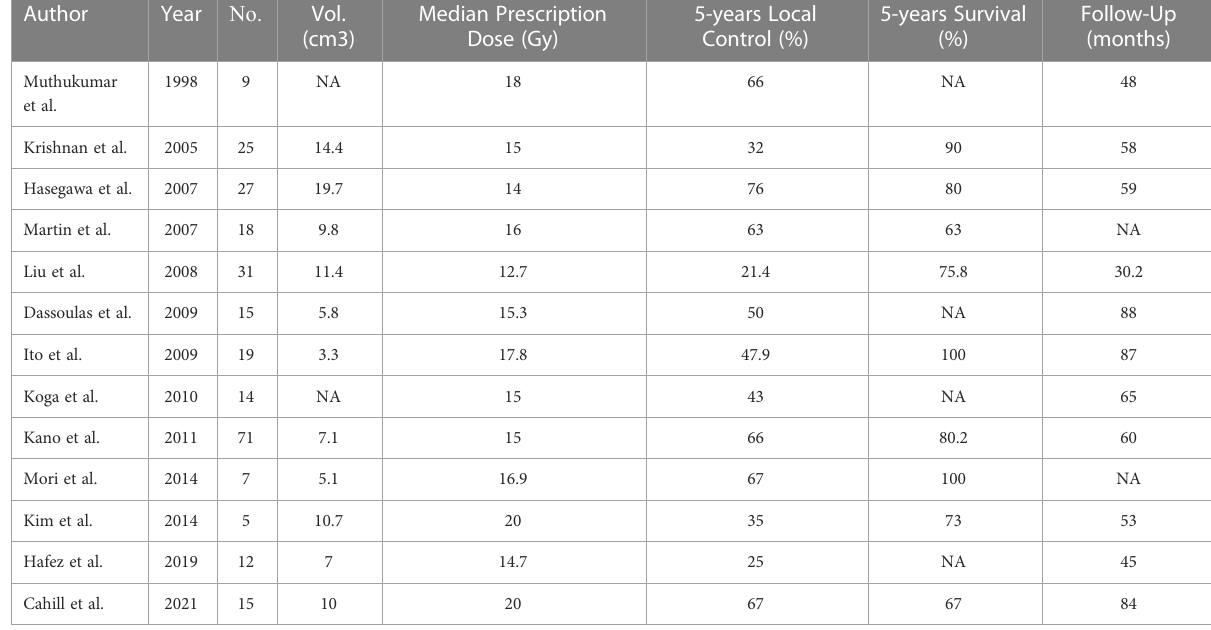
TABLE 3 Summary table of GKS studies for chordoma.